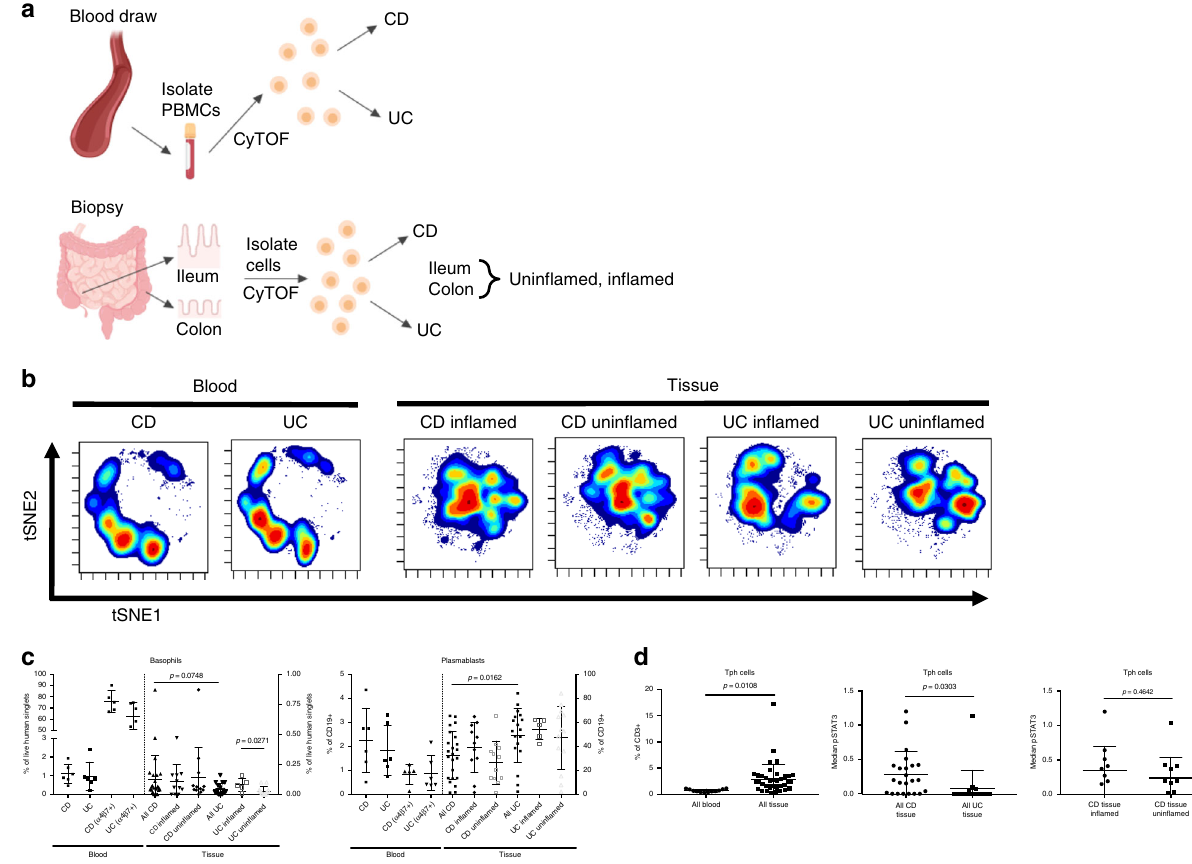
Fig. 4 Tissue contains immune responses distinct from blood. a Schematic of the study conducted on cohort 2. Blood was drawn and biopsies were collected from study subjects, peripheral blood mononuclear cells (PBMCs) and tissue leukocytes were isolated and cryopreserved, and samples were analyzed in batches by CyTOF. Created with BioRender. b viSNE based on 15 core lineage antigens (CD11c, CD11b, CD56, CD16, CD8, CD3, CD123, CD27, CD24, CD14, CD19, CD4, CD20, TCR γδ , and CD45RO) for samples from cohort 2. Sample sizes: CD blood = 6; UC blood = 6; CD in fl amed tissue = 11; CD unin fl amed tissue = 12; UC in fl amed tissue = 5; UC unin fl amed tissue = 13. c Signi fi cant differences between disease tissues consistent with trends observed in the blood from cohort 1. Statistics: unpaired two-tailed Student ’ s T test (Basophils: all CD vs. all UC tissue, t = 1.83, df = 39; UC in fl amed vs. unin fl amed tissue, t = 2.43, df = 16. Plasmablasts: all CD vs. all UC tissue, t = 2.51, df = 39). Sample sizes: CD blood = 6 (5 for α 4 β 7 + ); UC blood = 6; all CD tissue = 23; CD in fl amed tissue = 11; CD unin fl amed tissue = 12; all UC tissue = 18; UC in fl amed tissue = 5; UC unin fl amed tissue = 13. Center lines = mean; whiskers = standard deviation. d T peripheral helper (Tph) cells, de fi ned as CD3 + CD4 + CD45RO + CXCR5 − PD-1 + , in paired blood and tissue samples. Statistics: unpaired two-tailed Student ’ s T test (all blood vs. tissue, t = 2.65, df = 51; all CD vs. UC tissue, t = 2.25, df = 39; CD in fl amed vs. unin fl amed tissue, t = 0.75, df = 21). Sample sizes: all blood = 12; all tissue = 41; all CD tissue = 23; all UC tissue = 18; CD in fl amed tissue = 11; CD unin fl amed tissue = 12. Center lines = mean; whiskers = standard deviation. Source data are provided as a Source Data fi